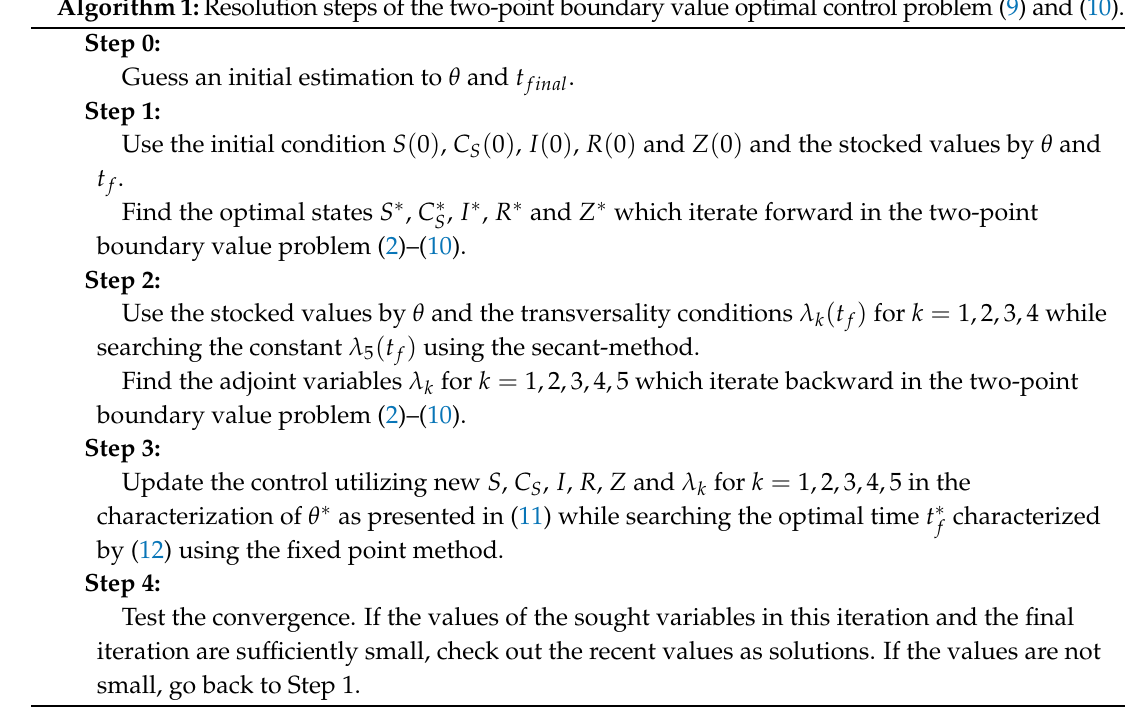
Algorithm 1: Resolution steps of the two-point boundary value optimal control problem (9) and